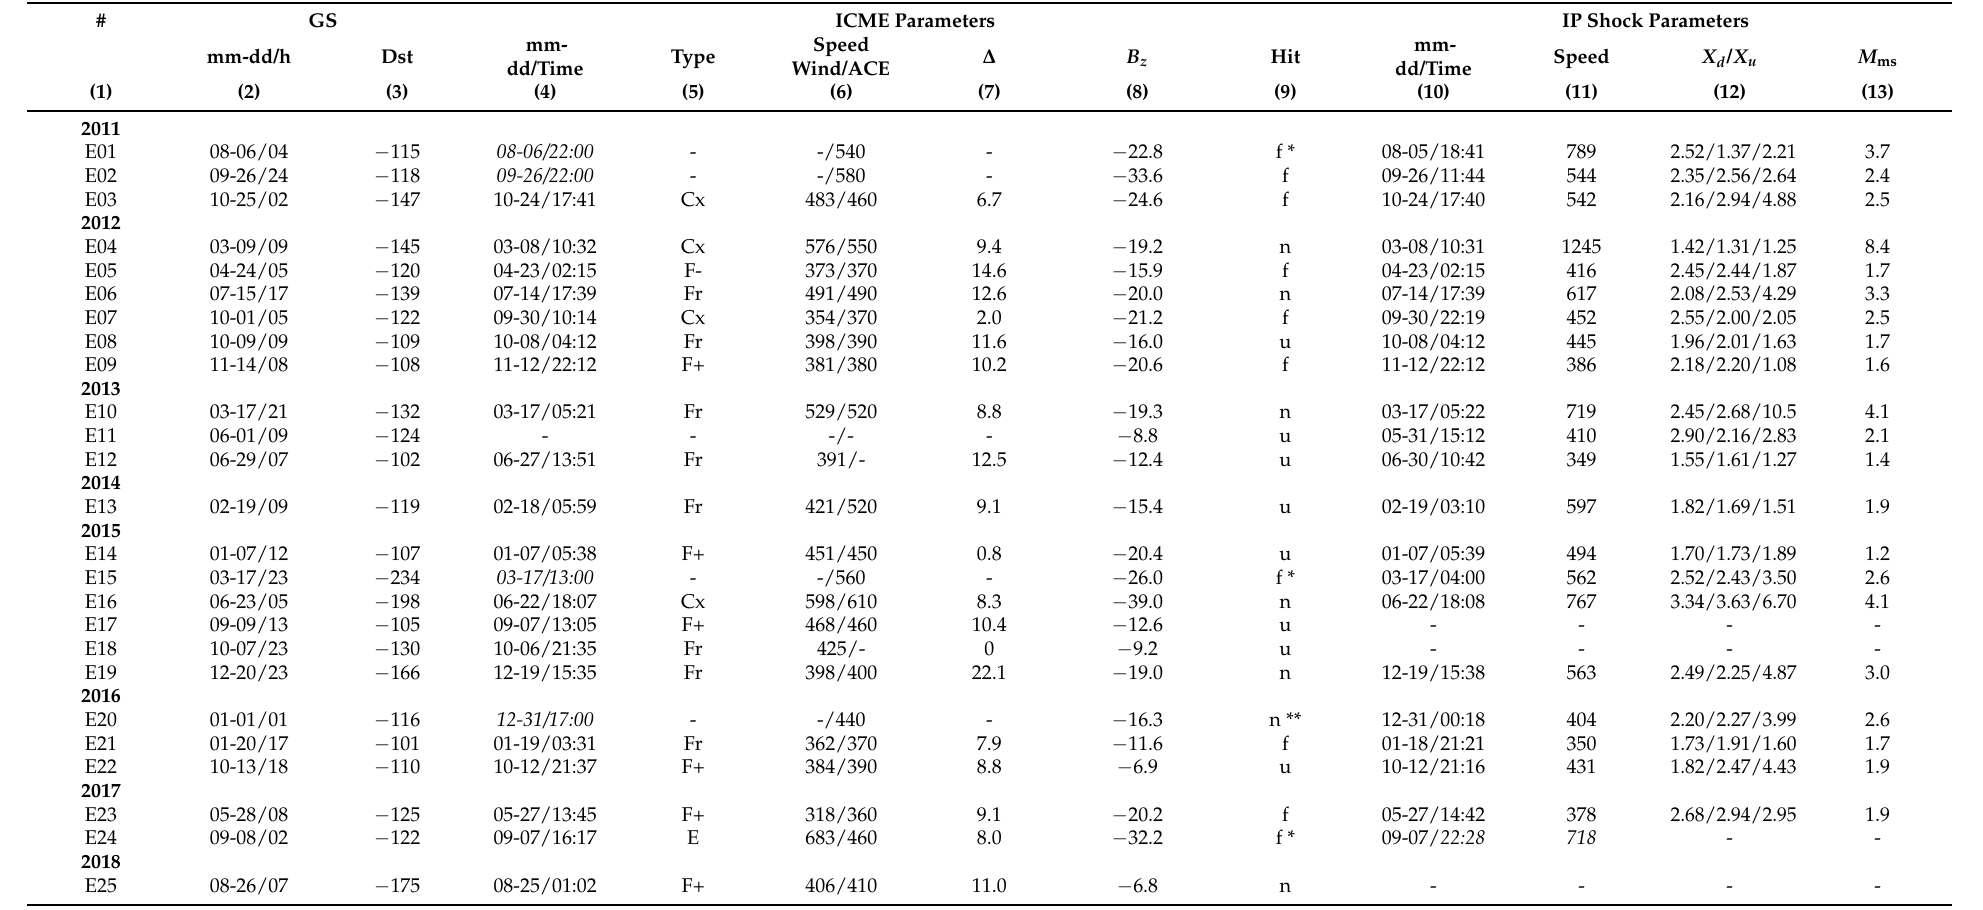
Table 1. Parameters of GSs, ICMEs and IP shock waves. Magnetic obstacle (MO) type: Flux-rope (Fr), Small rotation flux-rope (F-), Large rotation flux-rope (F+), Complex (Cx) or Ejecta (E). The date are given in month (mm), day (dd) and time (UT) format. Dst is in nT, speed in kms − 1 , ∆ (duration from ICME start to MO start) in hours, B z in nT, hit: n (nose), f (flank), */** (fast/slow speed), u (streamer/no clear ICME). Other abbreviations: #: event label; X : magnetic field/plasma density/temperature; d/u: downstream/upstream side of the shock interface; M ms : Mach